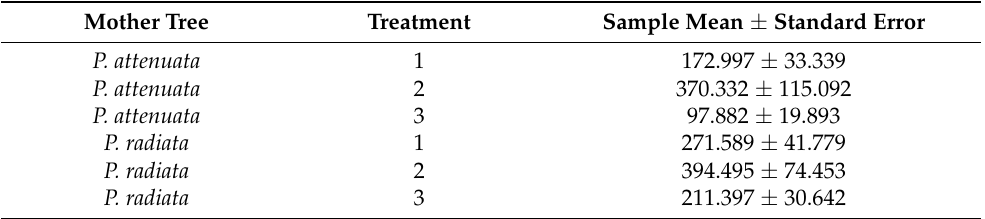
Table 3. Number of somatic embryos g − 1 fresh weight for the different levels of mother and initiation treatments (1, 2, and 3). Sample mean and its standard error.